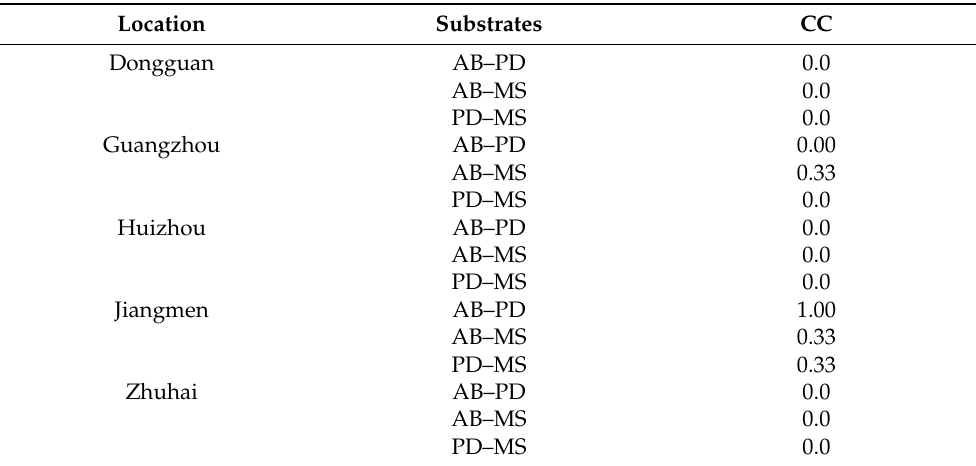
Table 5. The community coefficient (CC) of fungal taxa cultivated from different substrates within the individual sampling